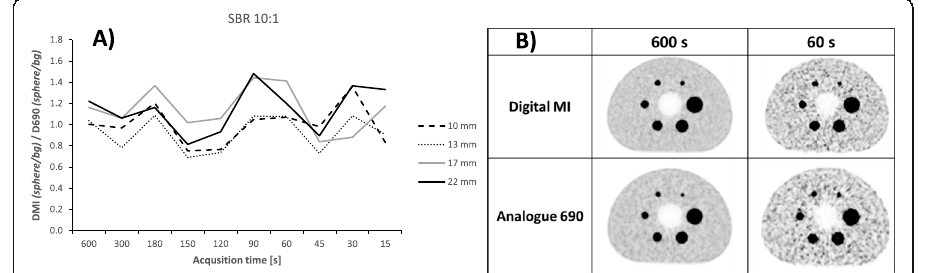
Fig. 2 a The ratio between the Discovery MI (DMI) and the Discovery 690 (D690) of the sphere peak / background peak ratio for acquisition times 600 – 15 s/bed in the NEMA body phantom. The hot spheres had diameters of 10 – 22 mm and the phantom was filled with SBR 10:1 with 18 F-FDG. b Images of the phantom with 600 and 60 s per bed position at an SBR of